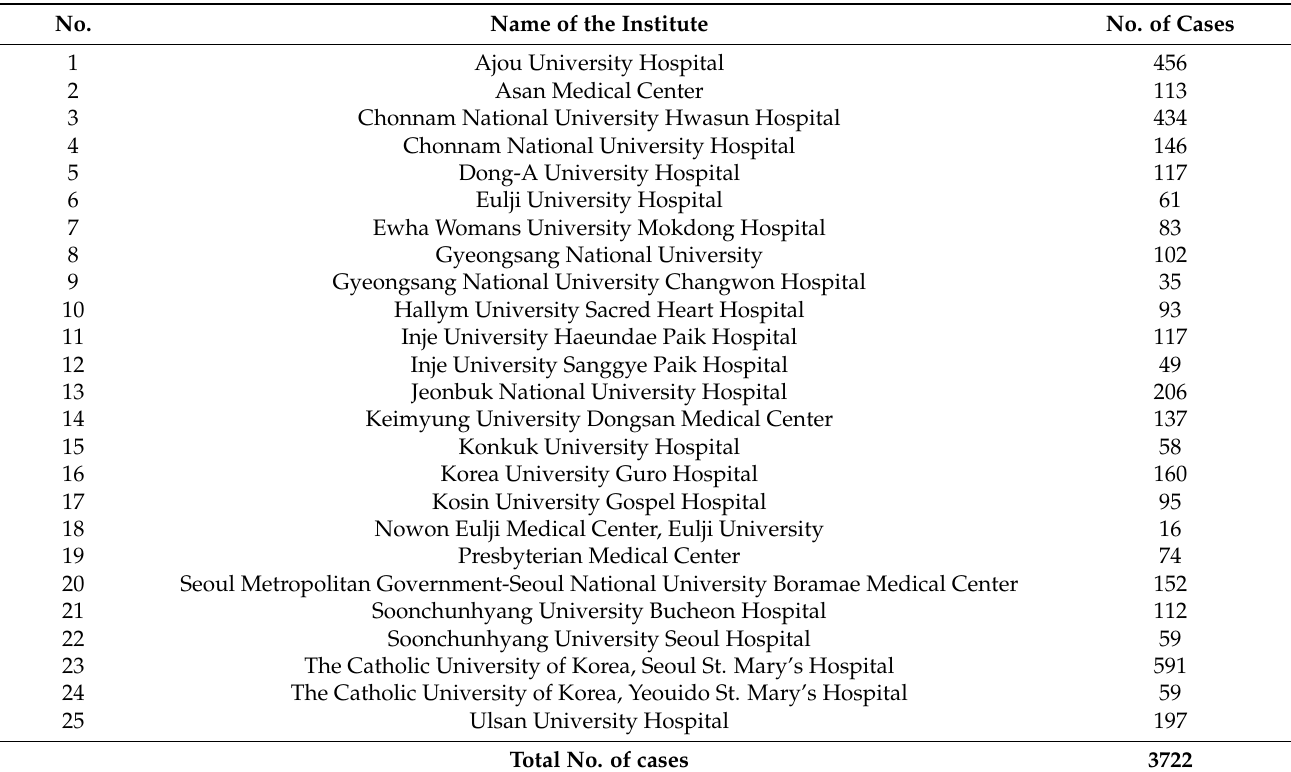
Table 1. Immunohistochemistry profile data from 25 university